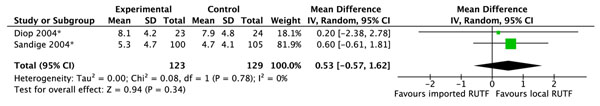
Forest plot for the effect of local vs. imported RUTF on weight gain in SAM